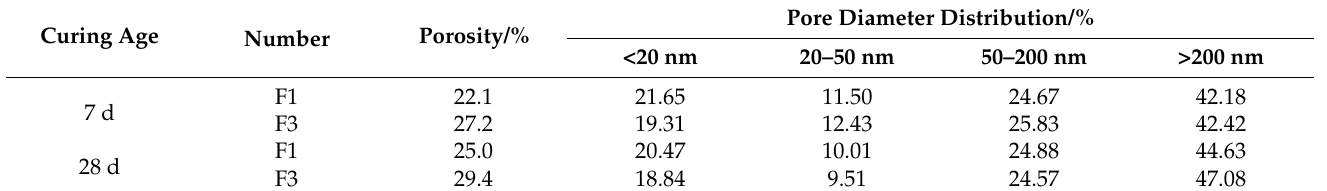
Table 2. Pore structure parameters of slurry in different curing ages.